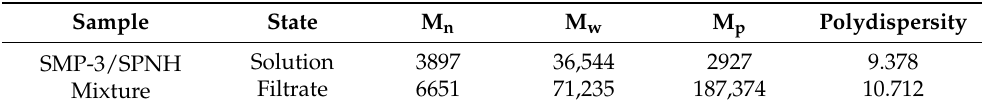
Table 1. Molecular weights of SMP-3/SPNH aged in the 7.0 wt.% KCl deionized aqueous solution and the filtrate.